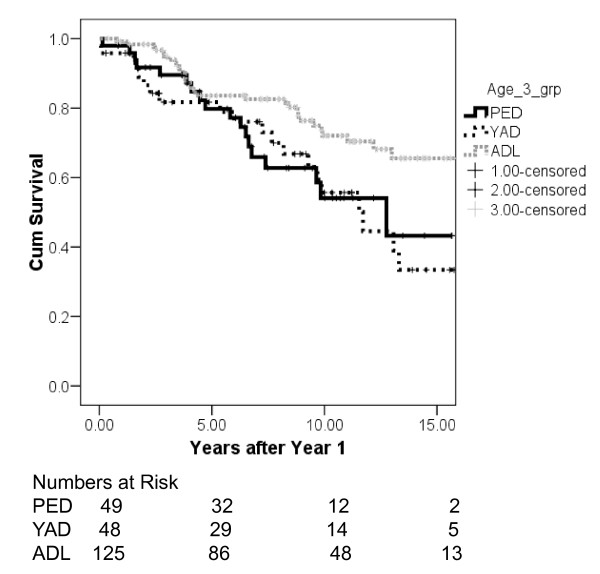
Death Censored Graft Survival (Kaplan-Meier) after year 1 and stratified by Age Group (PED, Pediatric; YAD, Young Adult age < 25; ADL, Adult age 25-35).